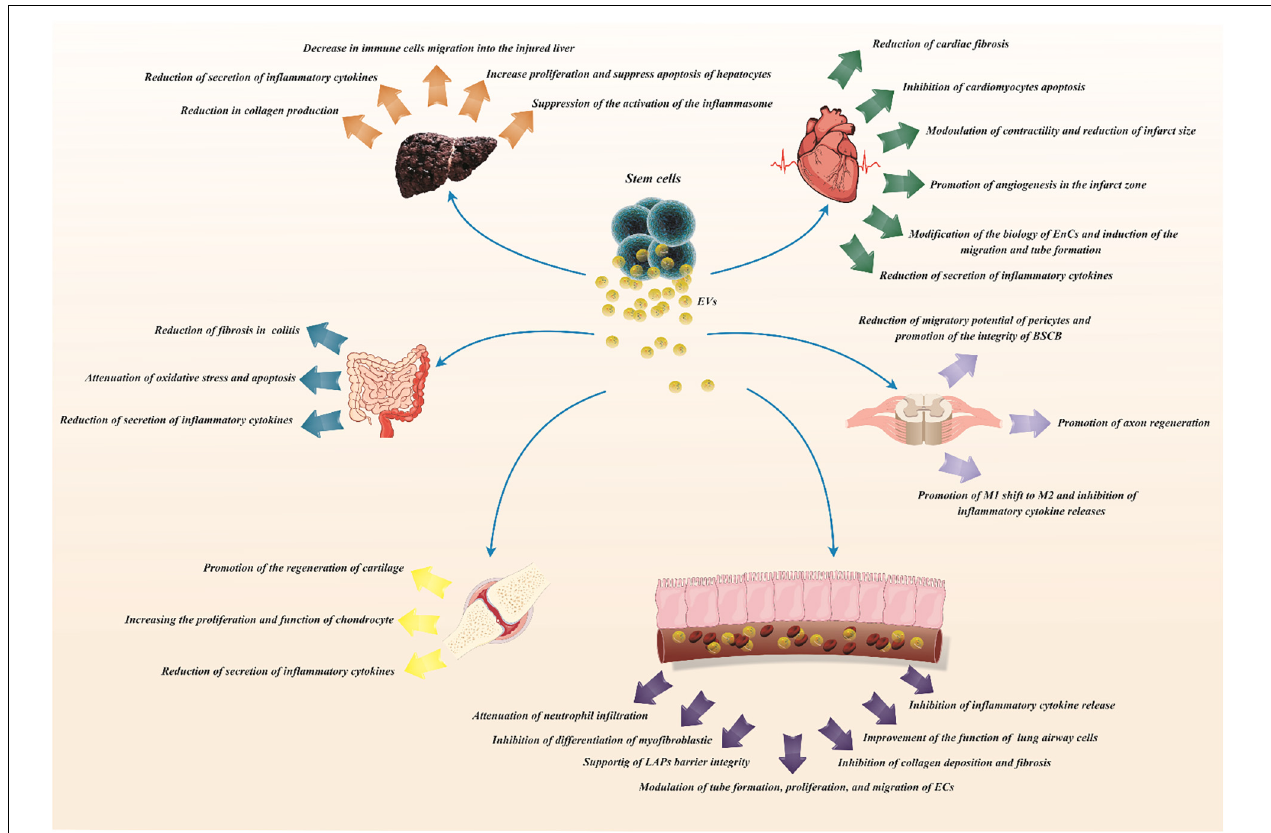
FIGURE 1 | Role of MSC-derived extracellular vesicles in the regeneration of different tissues.